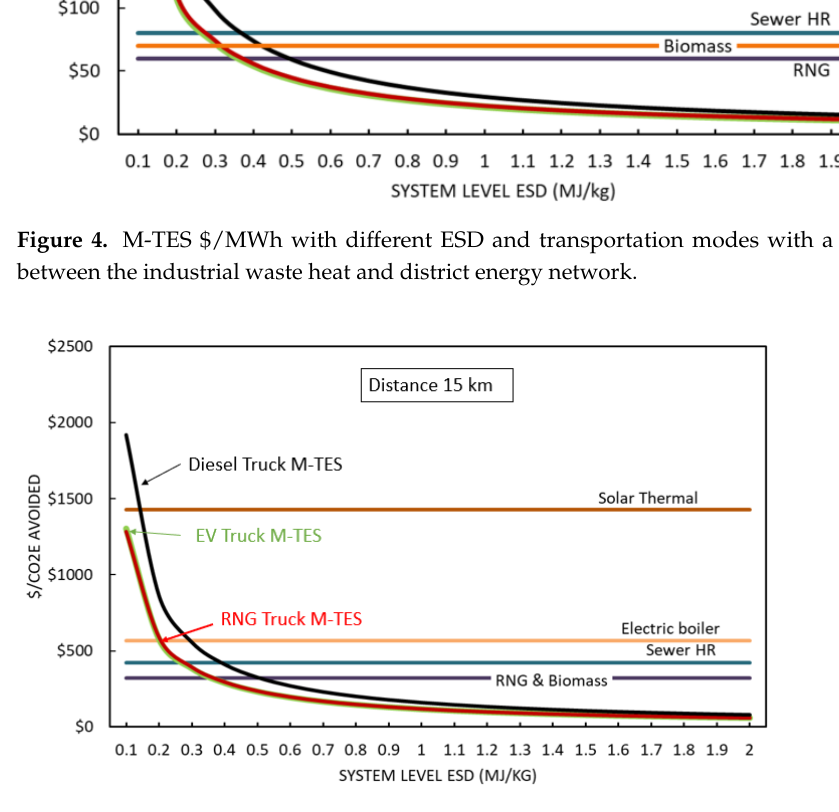
Figure 5. The avoided $/tCO 2 e with different System ESD and transportation modes with 15 km distance between the IWS and DEN.